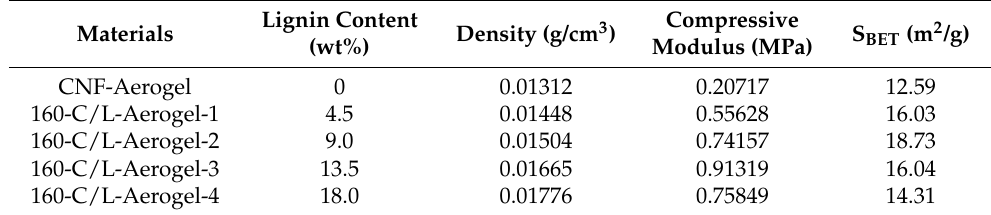
Table 1. Lignin content, density, mechanical properties, and specific surface area of CNF/nano-lignin aerogels and CNF